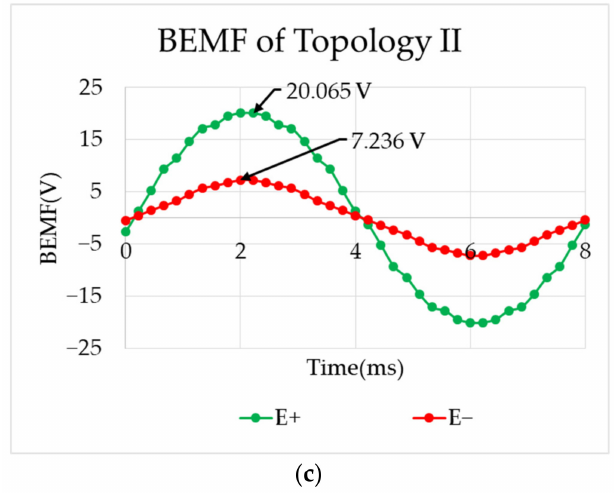
Figure 4. Back EMF of ( a ) isotropic VFS-PMSM, ( b ) Topology I, and ( c ) Topology II at enhancing and weakening ( E r iso _ VFS = 8.39, E r T − I = 3.18 V, E r T − II = 12.83